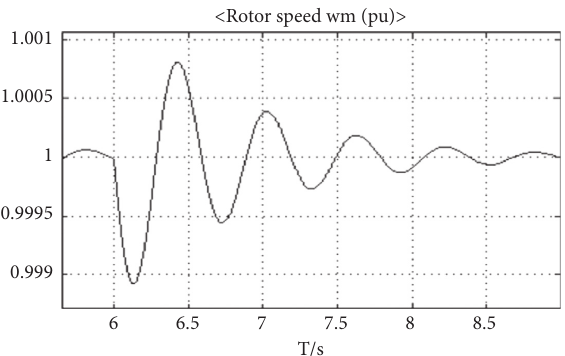
Figure 13: Rotation speed fluctuation after small